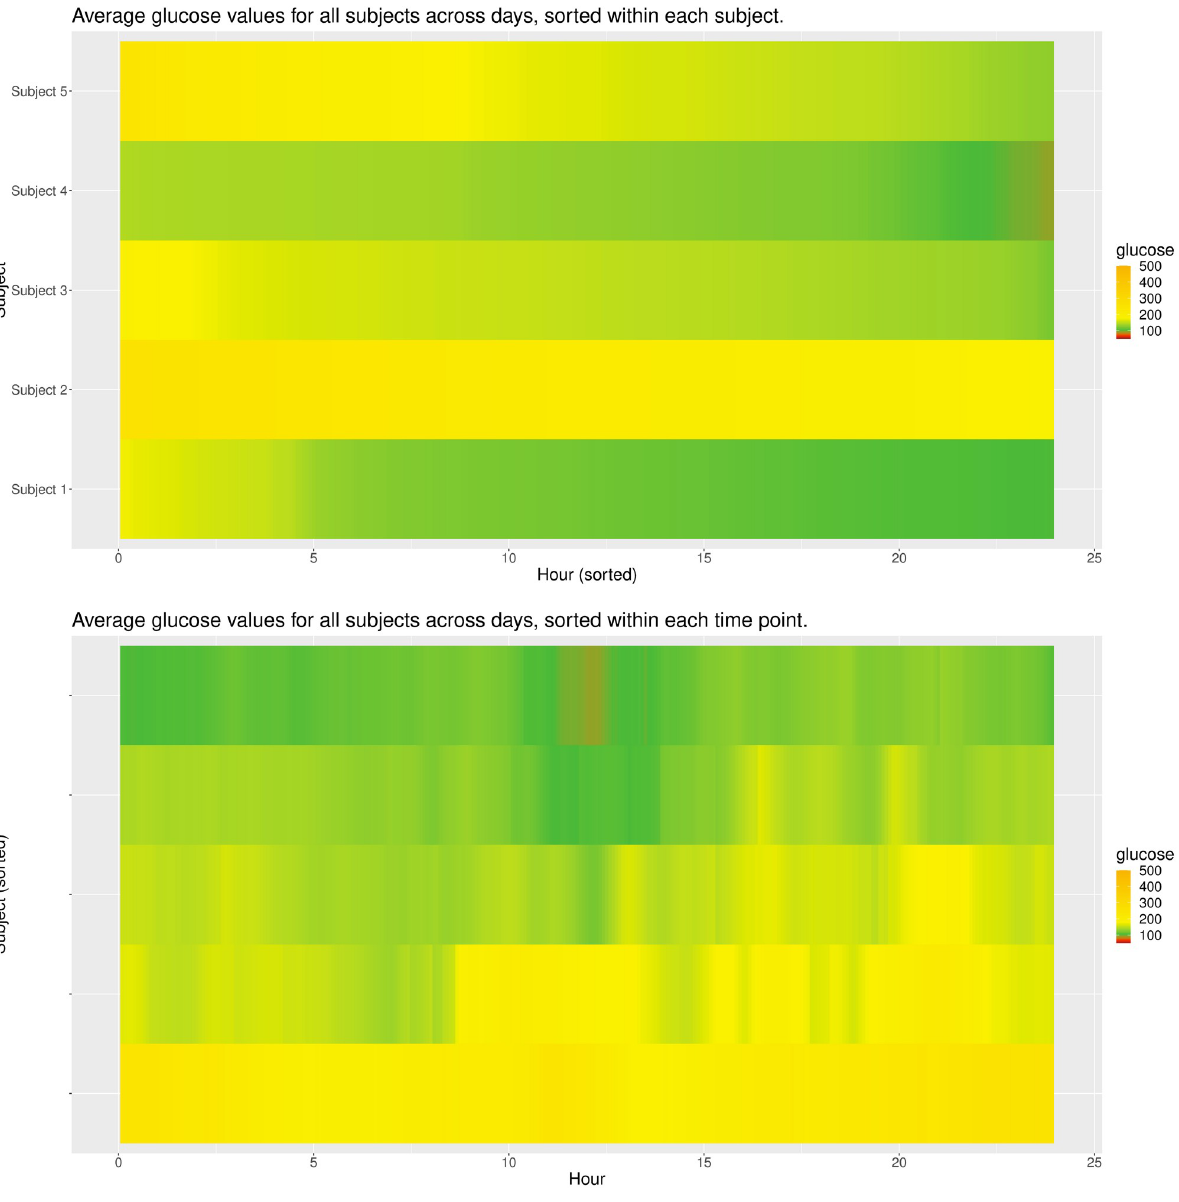
Fig 3. Multi-subject lasagna plots in ‘red-orange’ color scheme. (A) sorted within each subject and (B) sorted within each time point across subjects. (centered and scaled across all subjects to aid visualization) created using R package pheat- map [30]. The hierarchical clustering of glucose metrics results in six meaningful groups with the following interpretation (from top to bottom): (1) in range metrics; (2) hypoglycemia met- rics; (3) hyperglycemia metrics; (4) a mixture of variability and hyperglycemia metrics; (5) CVsd (standard deviation of CV, coefficient of variation, across days); (6) glucose variability metrics. Interestingly, while CVsd is a measure of glucose variability, it behaves quite differ- ently from other variability metrics in these 5 subjects. The hierarchical clustering of subjects confirms our previous observations that Subject 2 has the worst hyperglycemia (highest values